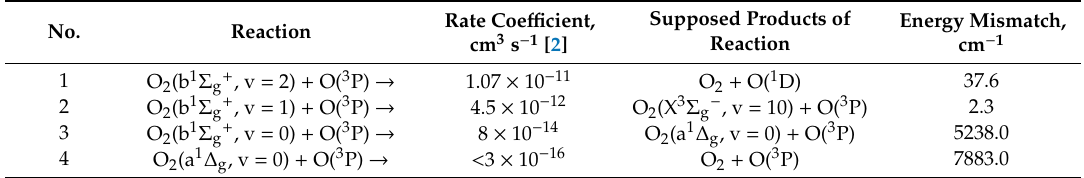
Table 2. Possible correlation between a reaction energy mismatch and value of the rate coe ffi cient at thermal